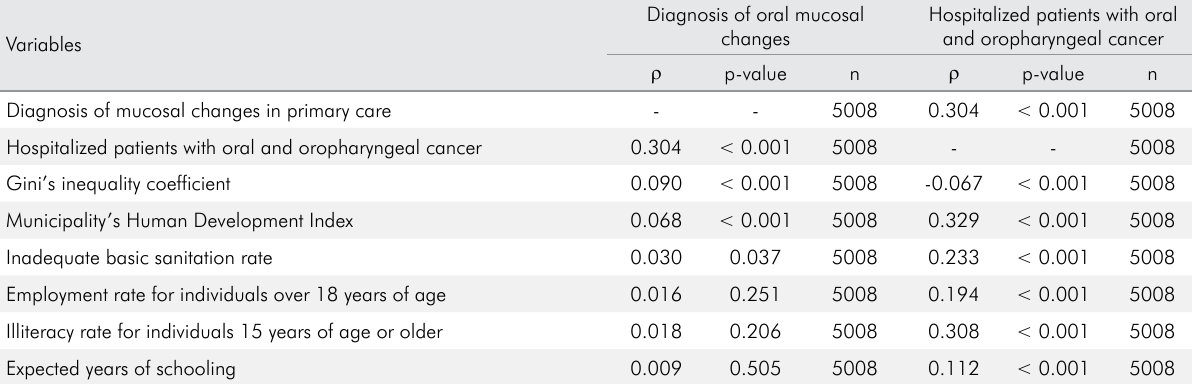
Table 2. Spearman’s bivariate correlation matrix for dependent and independent variables.